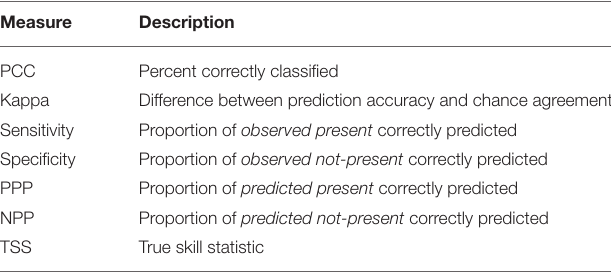
TABLE 3 | Evaluation metrics of accuracy based on the confusion matrix from Miller